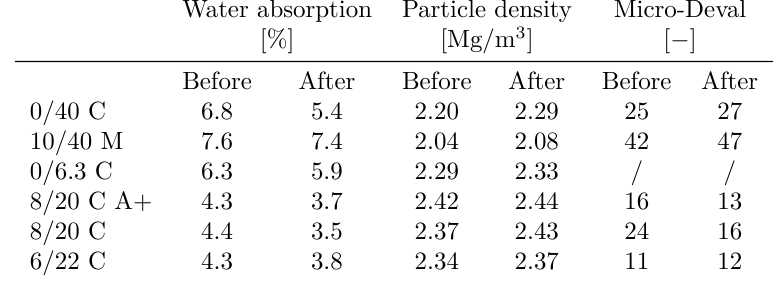
Table 4. Characterization of the treated aggregates.